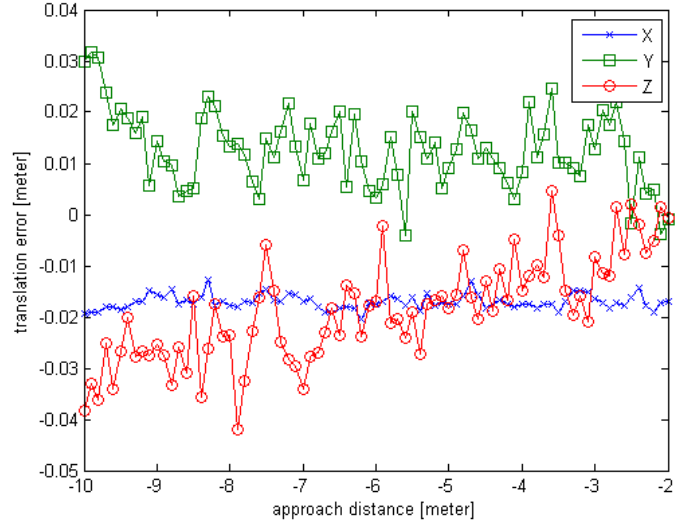
Figure 13. The translation error curve of Experiment 4 for relative motion.